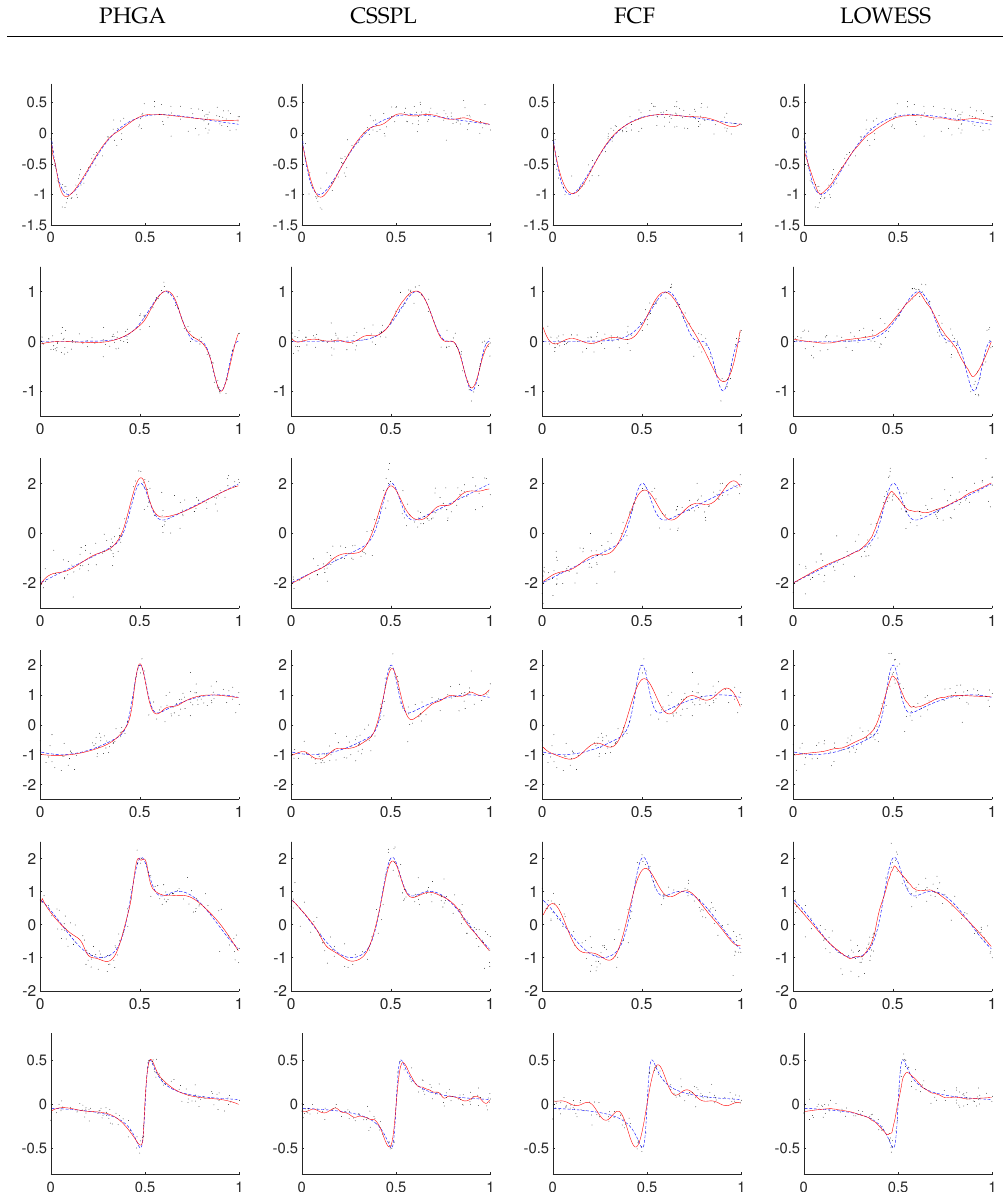
Figure 7. Data and best fitting with SNR = 3 for parallel hierarchical genetic algorithm (PHGA), cubic smoothing spline (CSSPL), Fourier curve fitting (FCF) and locally weighted scatterplot smoothing (LOWESS) methods (solid line: estimated function; dashed line: real